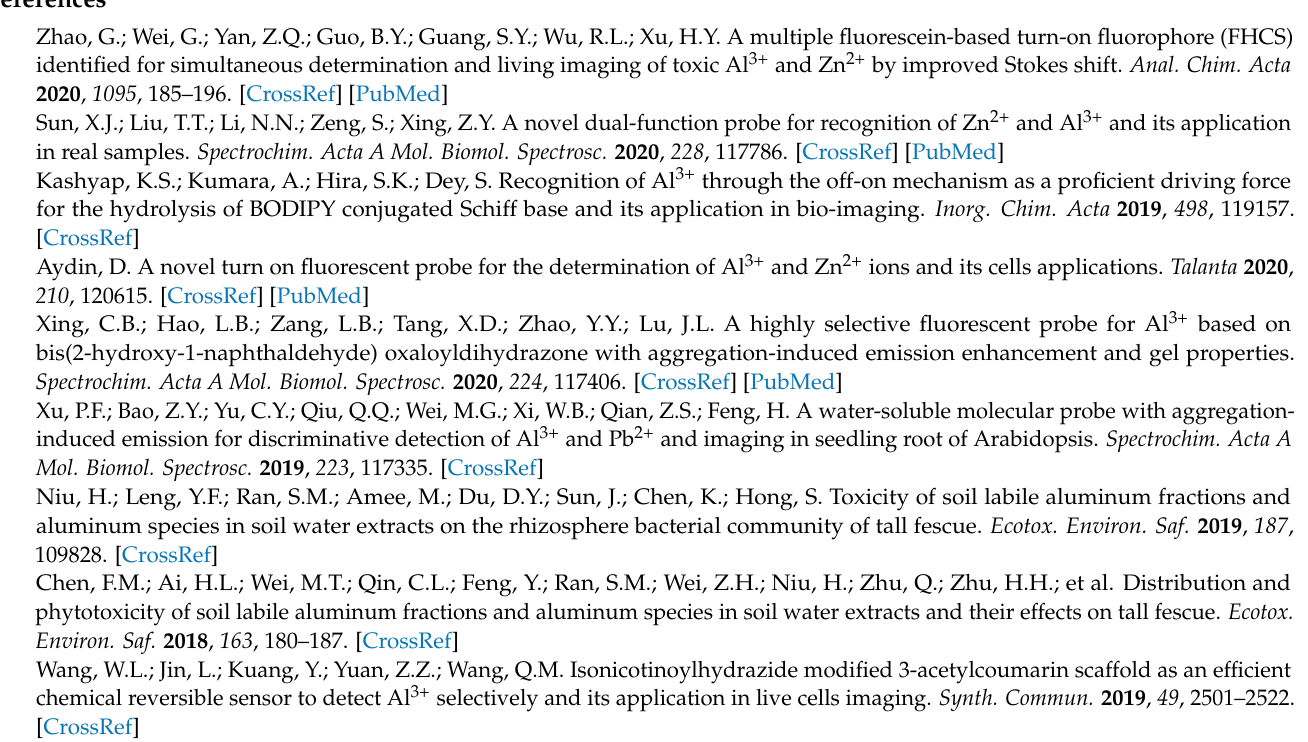
Reversibility of BHMMP for Al 3+ Figure S6. Fluorescent response of probe BHMMP in actual water samples. Figure S7. The cell viability of probe BHMMP. Figure S8. 1 H NMR spectrum of probe BHMMP. Figure S9. 13 C NMR spectrum of probe BHMMP. Figure S10. ESI-MS spectrum of probe BHMMP in DMF. Table S1 Comparison of previously reported Al 3+ probes with functional groups similar to BHMMP. Table S2 The fluorimetric determination results for Al 3+ in actual water samples by probe